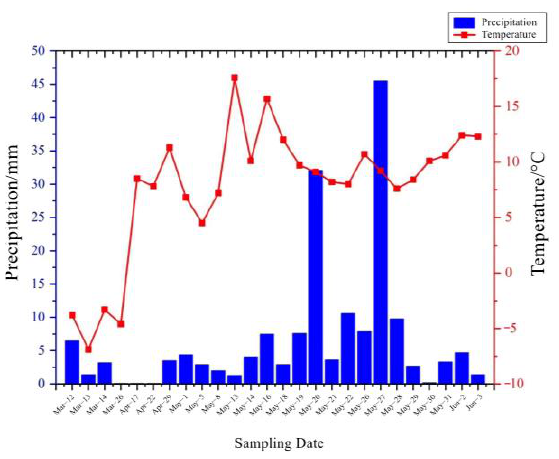
Figure 2. The change of temperature and precipitation amount in Wuying during the time of the experiment.